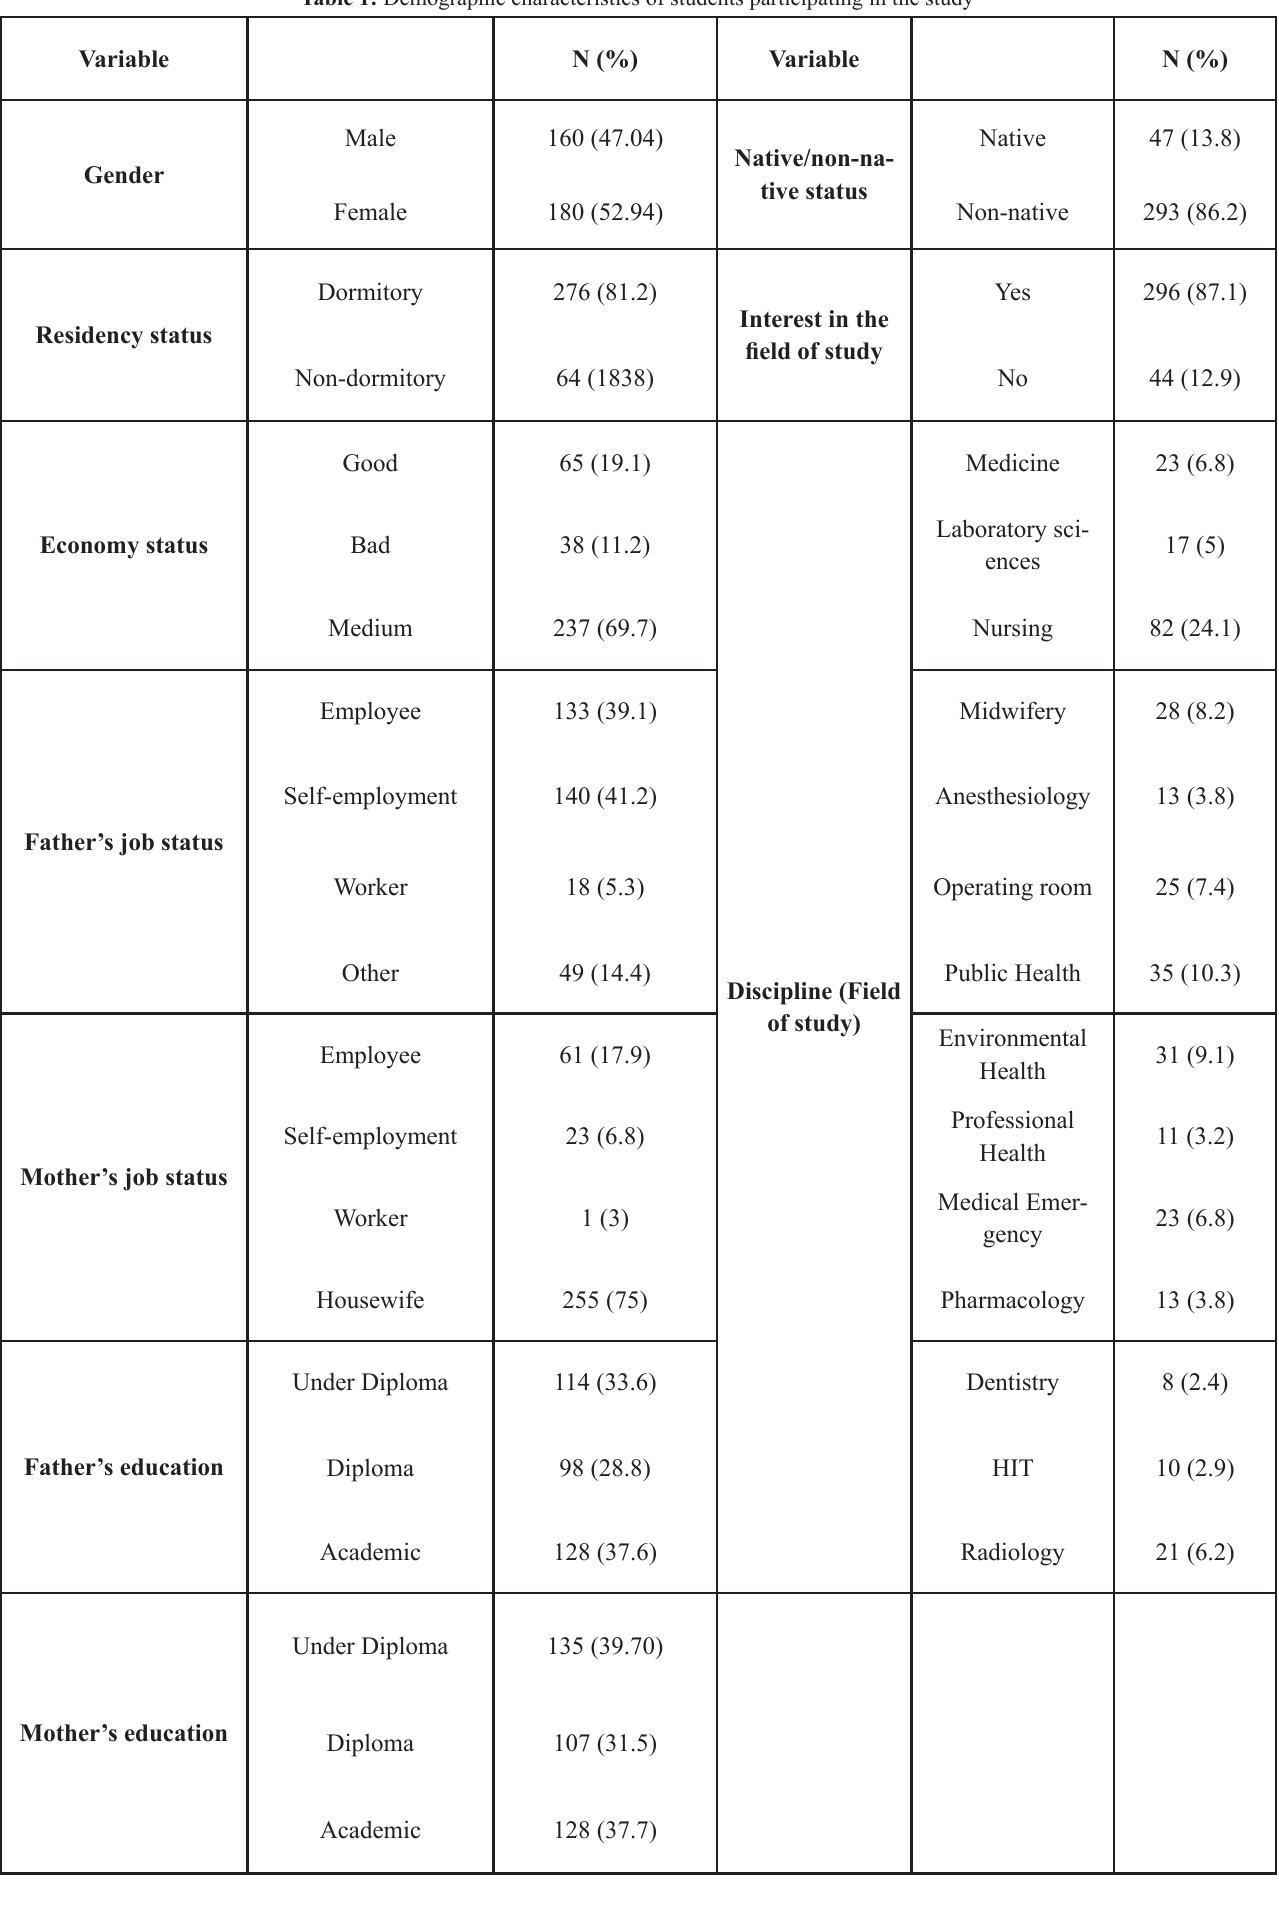
Table 1: Demographic characteristics of students participating in the